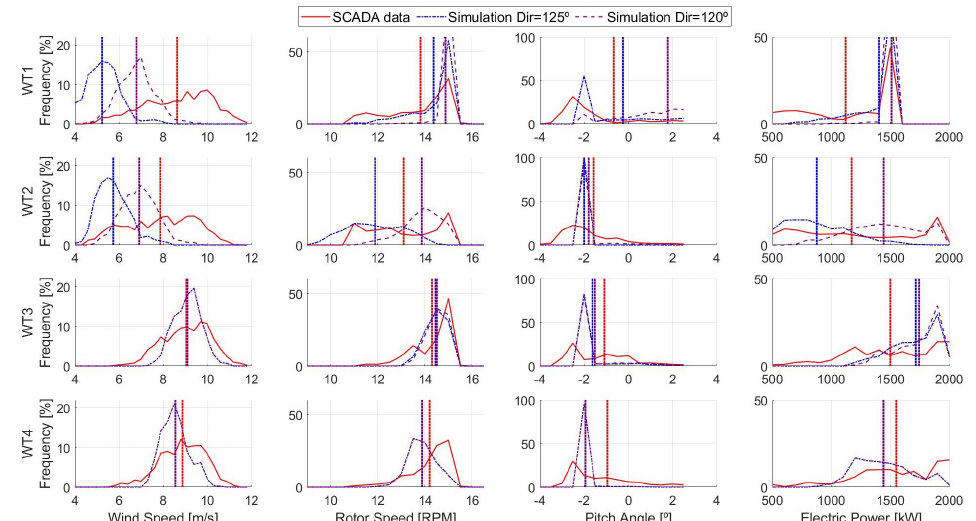
Figure 7. Histograms of wind speed (m/s), rotor angular speed (RPM), pitch angle ( ◦ ), and electric power (kW) from the SCADA data and simulation of wind turbines WT1, WT2, WT3, and WT4. Inflow condition of the simulation: Wind direction 120 ◦ and 125 ◦ (wake interaction) and wind speed close to rated. Vertical dashed lines represent the mean value of each signal.